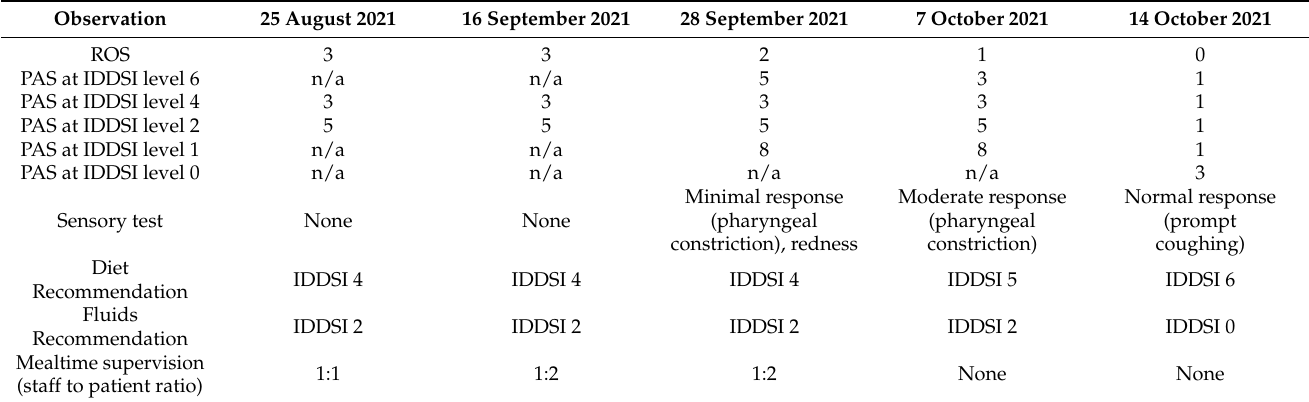
Table 3. Fiberoptic Endoscopic Evaluation of Swallowing (FEES) findings during the patient’s rehabilitation